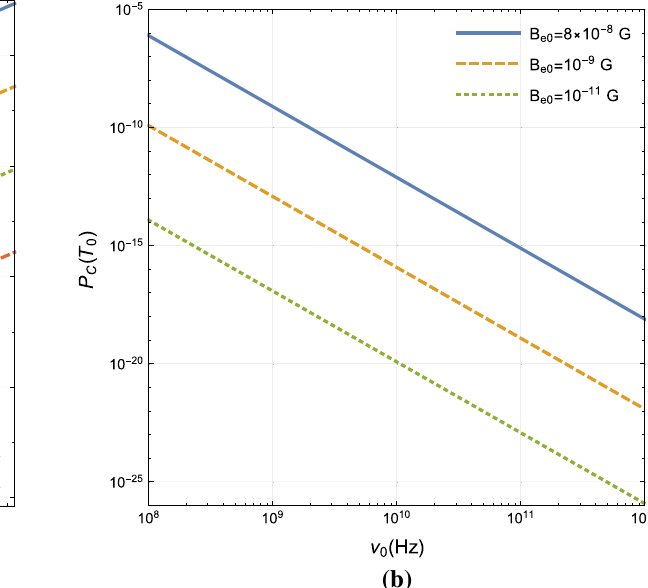
circular polarization P C ( T 0 ) as a function of the CMB frequency ν 0 for values of B e 0 = 8 × 10 − 8 G, B e 0 = 10 − 9 G and B e 0 = 10 − 11 G are shown.Inbothplots a and b weusedavalueof | r | = 1and | Q i | = 10 − 6 where r ≡ U i / Q i . The grey lines in both a and b are simply grid lines